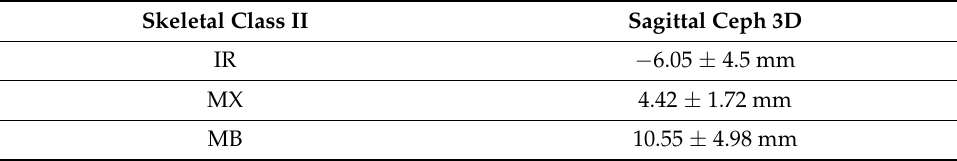
Table 5. Results obtained for Skeletal Class I following analysis employing the Sagittal Ceph 3D